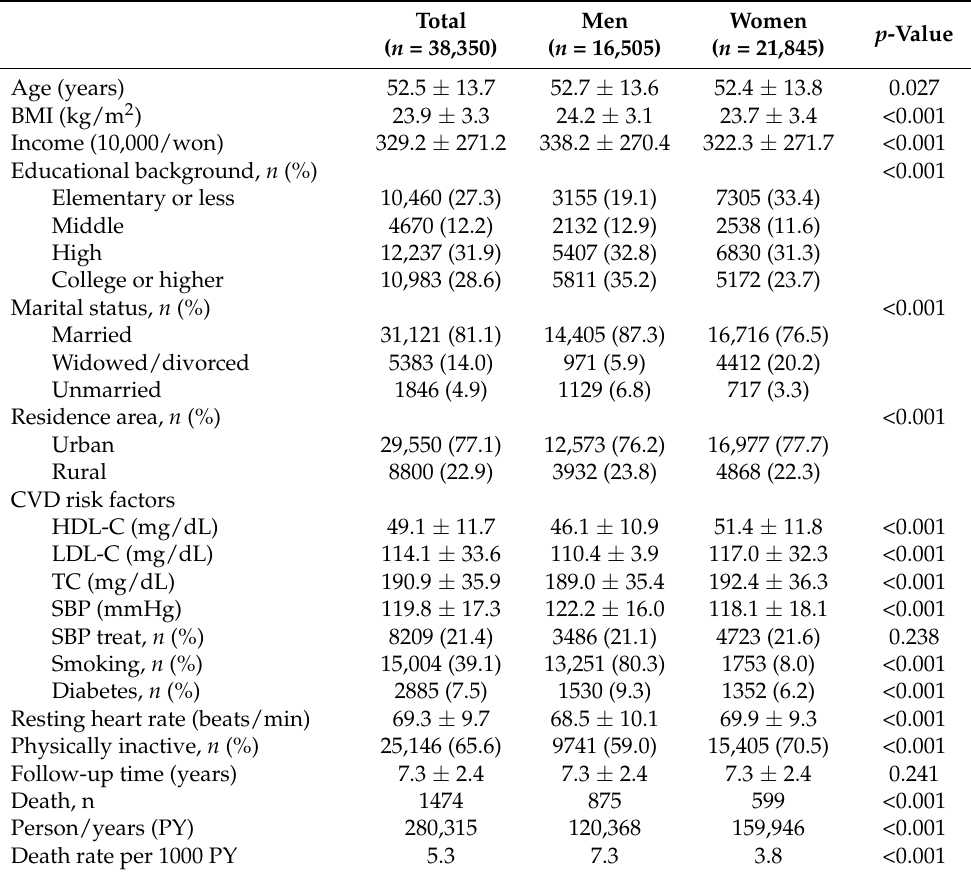
Table 1. Characteristics of study